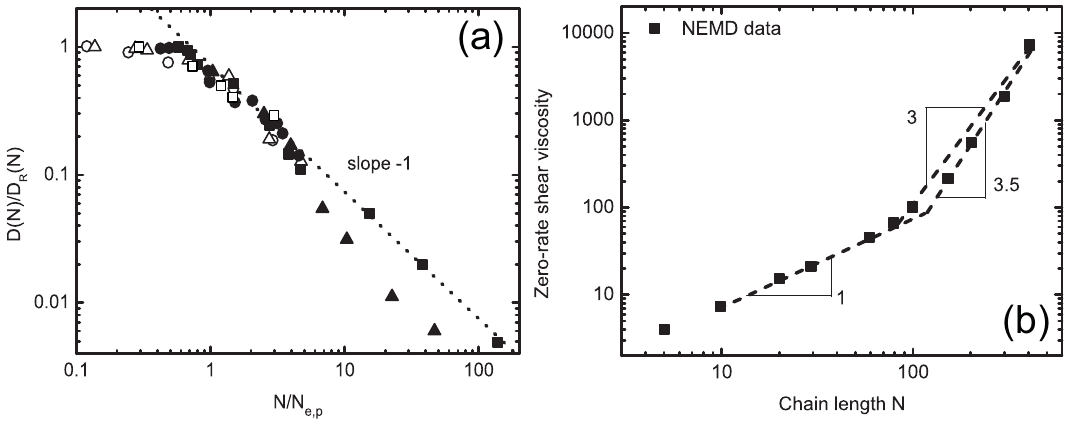
Figure 4. Results of ( a ) self-diffusion coefficient and ( b ) zero-rate shear viscosity of finite-extensible non-linear elastic (FENE) chains. In ( a ), the scaled diffusion coefficient, D ( N ) /D ( N ) , is plotted against the scaled chain length, N/N , for polystyrene (closed R e,p = 140 and T = 485 K [111]), polyethylene (closed squares N = 31 circles N e,p e,p = 18 and and T = 448 K [112]), hydrogenated polybutadiene (closed triangles N e,p T = 448 K [113]), FENE (open triangles N = 72 [105]), bond-fluctuation model (BFM) e,p (open squares Φ = 0 . 5 [94]) and tangent hard spheres (open circles Φ = 0 . 45 [114]). In ( b ), the data are reproduced with permission from